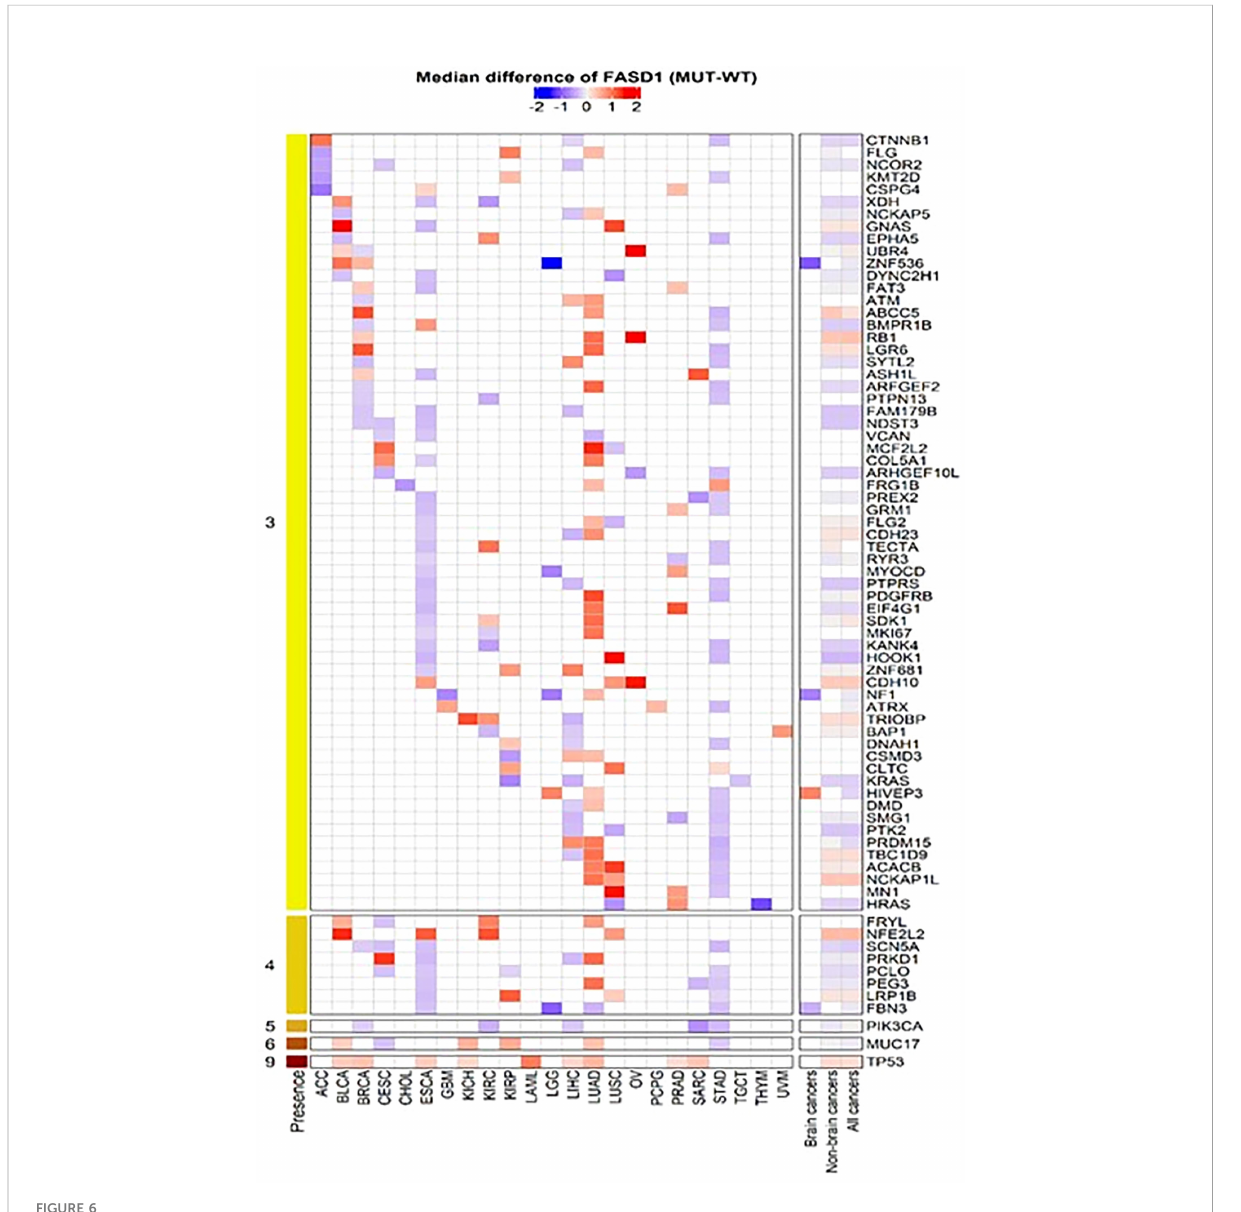
FIGURE 6 Heatmap of mutated genes associated with FADS1. For each cancer type, we selected genes that had signi fi cantly different FASD1 expression levels between mutation (MUT) and wildtype (WT) in at least three individual cancer types. The Wilcoxon rank-sum test was used to compare the FADS1 expression levels between MUT and WT for each cancer